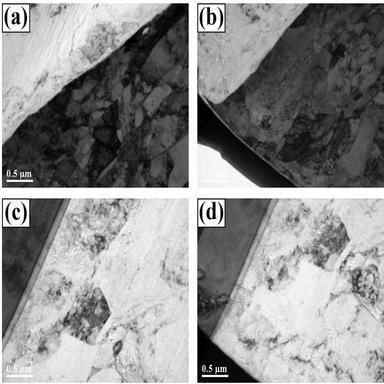
FIB/TEM images showing the formation of UFG structures inside the (a, b) nickel foil layers and (c, d) magnesium matrix after the accomplishment of the subsequent fold-forging steps. In these TEM images, the white contrast demonstrates the magnesium matrix, and the grey difference indicates the nickel foil layers.